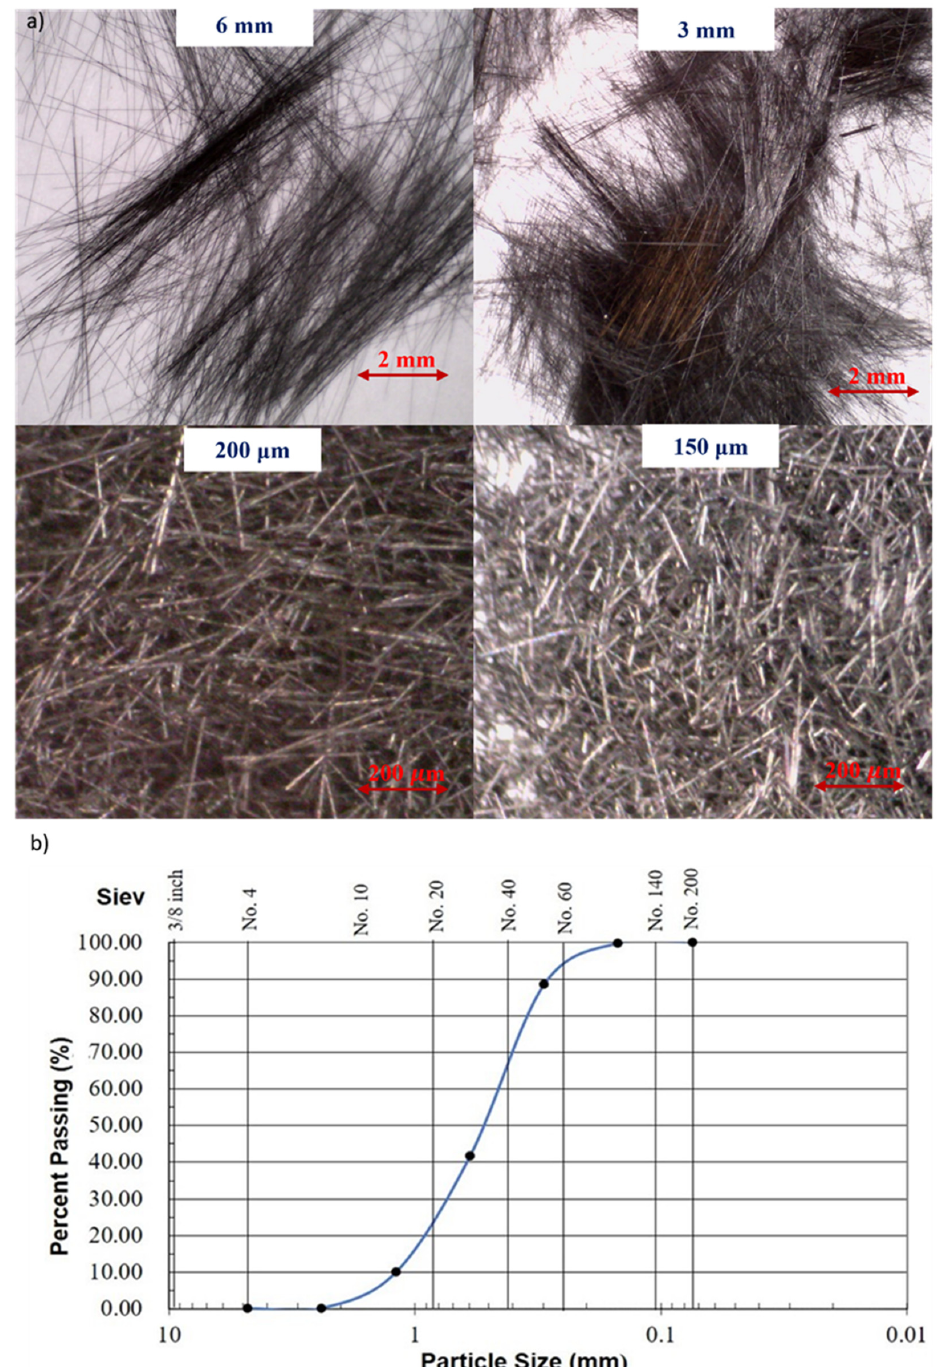
Figure 1. ( a ) Light microscopic images of CCMFs and MCMFs, and ( b ) particle size distribution of the fine aggregate.